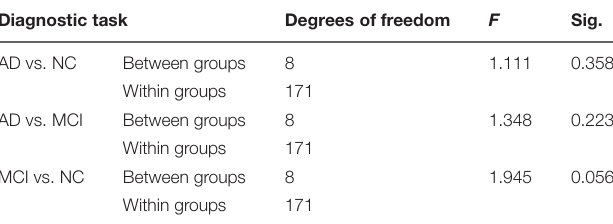
TABLE 3 | One-way ANOVA test on the classification performance of nine tractography algorithms for three diagnostic tasks when using the raw matrices as